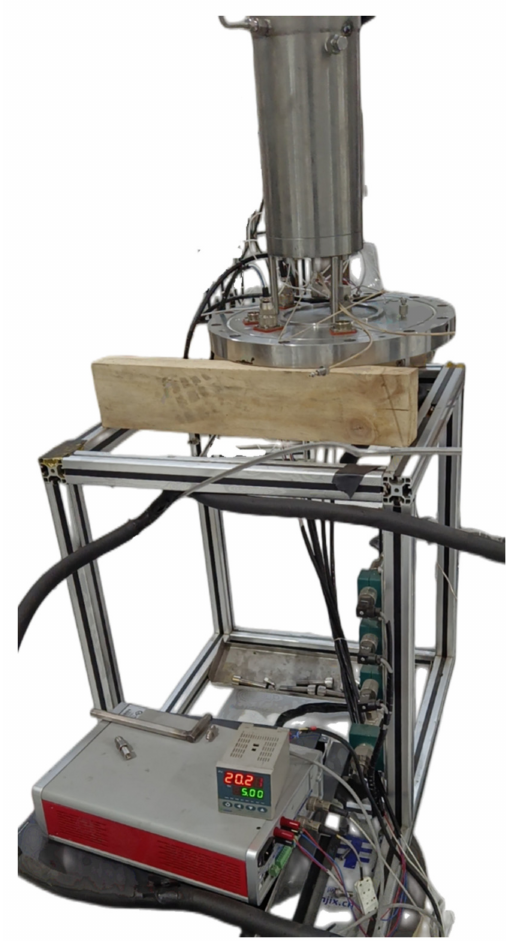
Figure 10. Pressure resistance